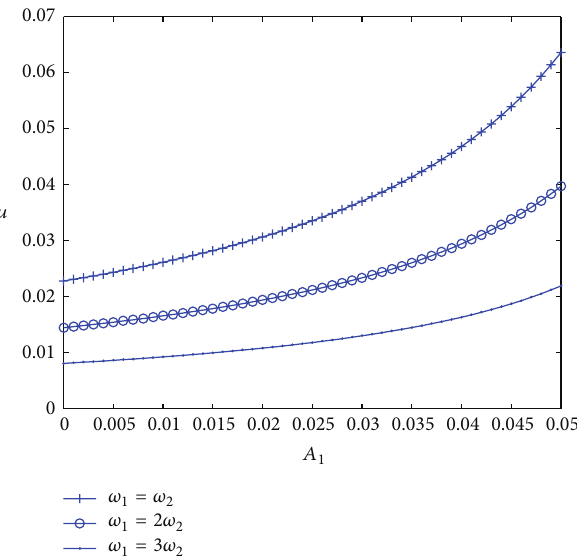
Figure 10: Correlation between 𝜇 and 𝐴 1 and 𝛽 1 = 0.01 , 𝛽 2 = 0.02 , and 𝐴 2 = 0.05 .